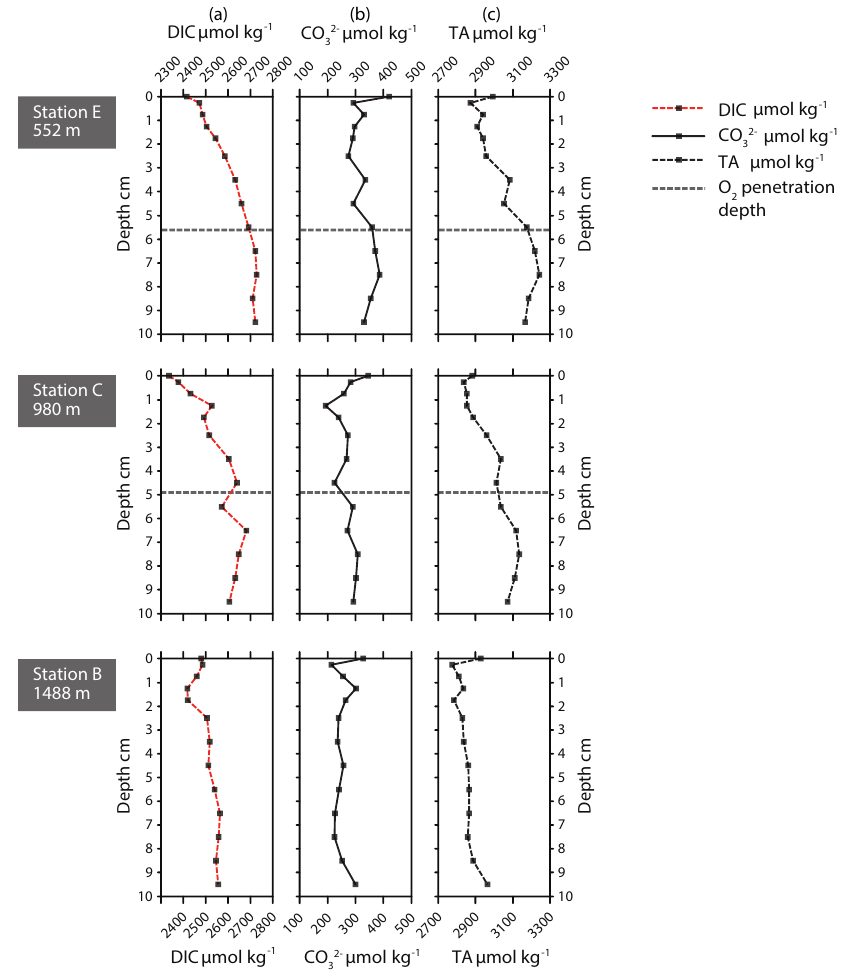
Figure 4. Carbonate chemistry parameters for stations E, C, and B. (a) Dissolved inorganic carbon (DIC), (b) [CO 2 − (c) total alkalinity (TA) in µmolkg − 1